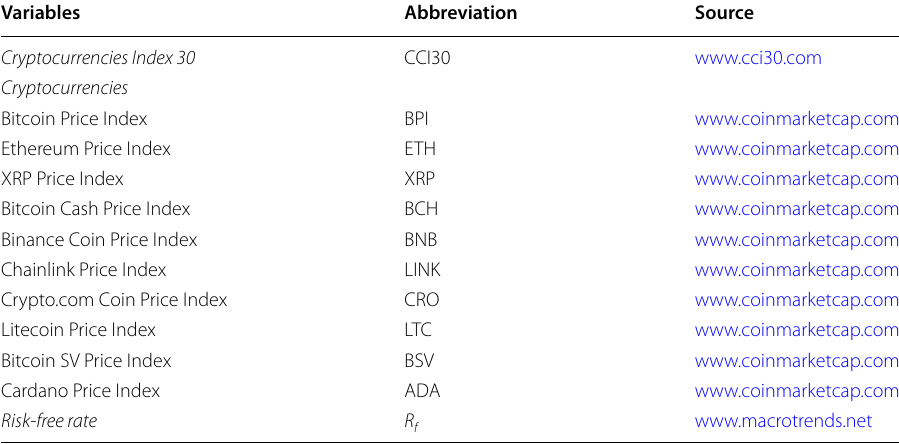
Table 1 Variables, abbreviations, and